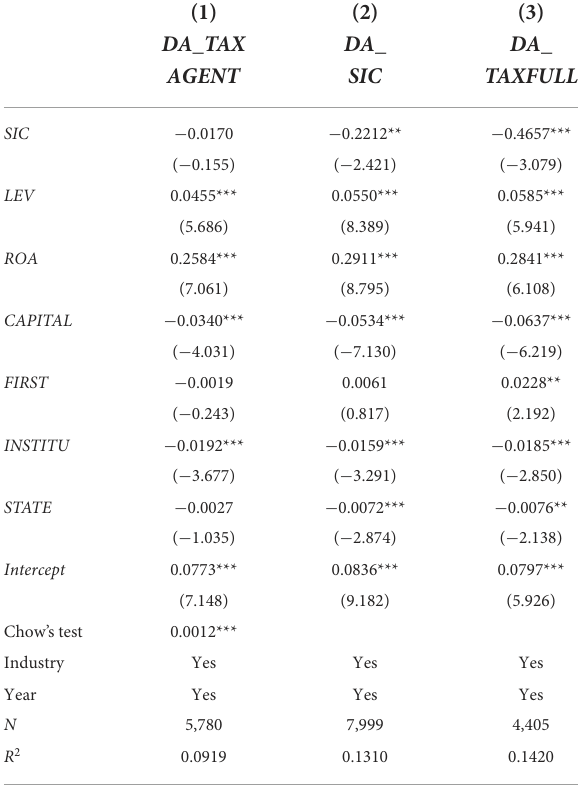
TABLE 14 External corporate governance categorized by collecting